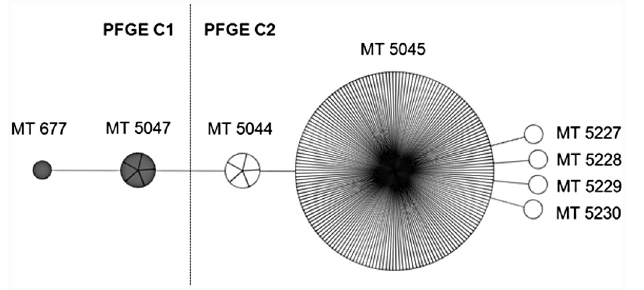
Fig 1. Minimum spanning tree of the 8 different MLVA types found in 194 ST8-MRSA-IV-t304-PVL- negative isolates from 1998 – 2013. Short lines indicate difference in one VNTR, whereas long lines indicate difference in two VNTRs. The size of the circles corresponds to the number of isolates. MLVA types within PFGE cluster 1 (C1) is marked in grey, whereas MLVA types within PFGE C2 are white.